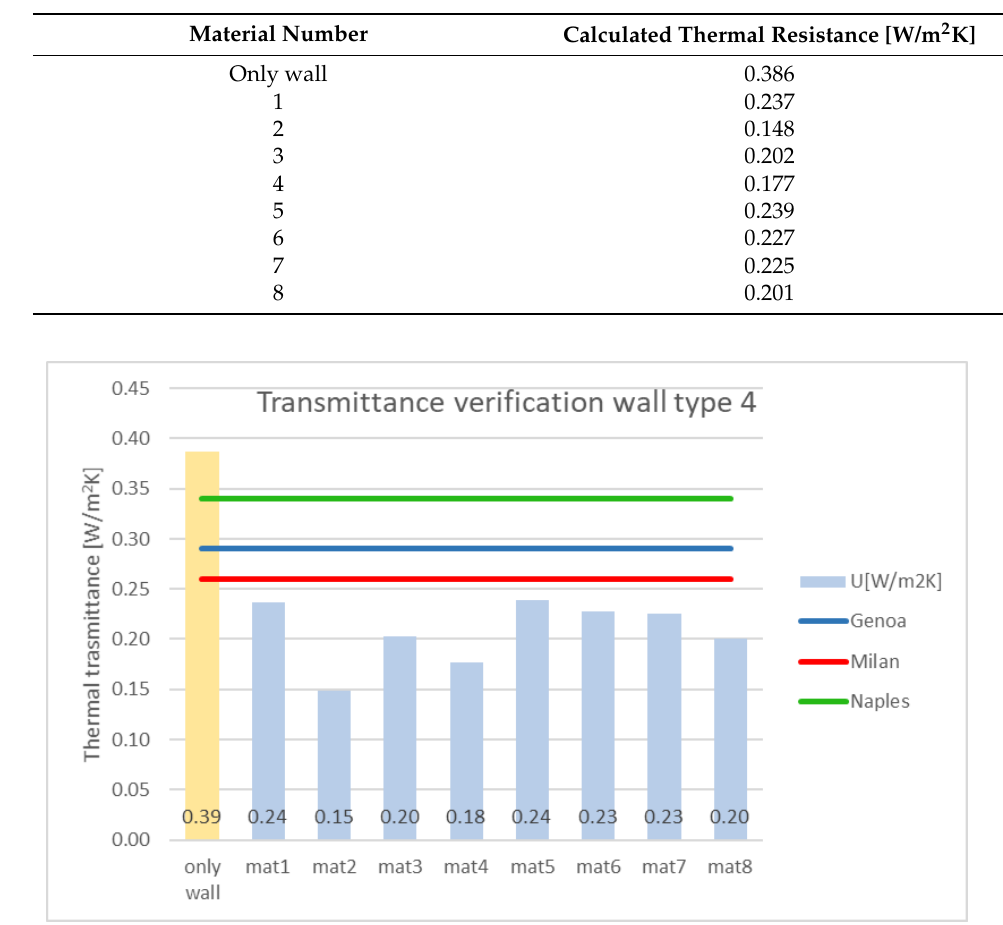
Figure A12. Wall type 4: transmittance check for the three main Italian climatic zones. In are blue the heat-reflective materials which respect all the limits.